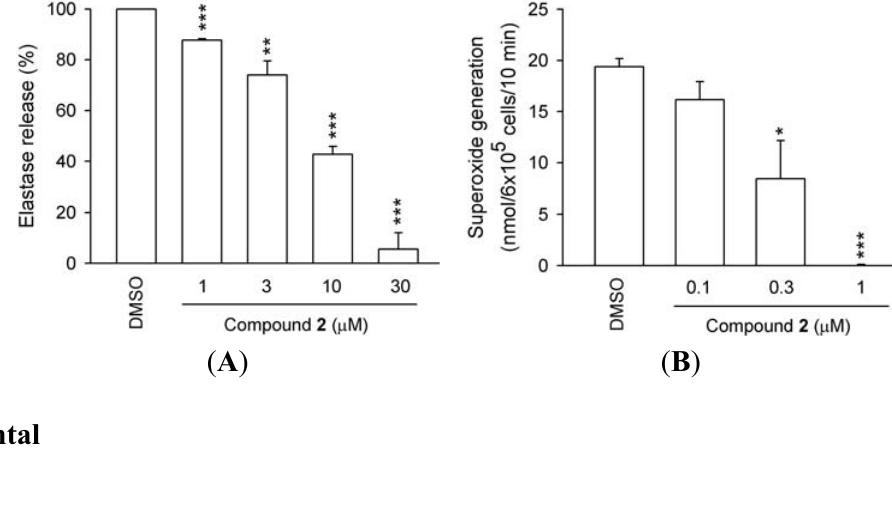
Figure 4. Concentration-dependent effects of compound 2 on O 2• − production and elastase release in human neutrophils. Human neutrophils were preincubated with DMSO (control) or compound 2 for 5 min before activation by FMLP/CB. ( A ) O 2• − production and ( B ) Elastase release was induced by FMLP/CB. All data are expressed as the mean ± S.E.M. ( n = 3). * p < 0.025; ** p < 0.01; *** p < 0.001 compared to the